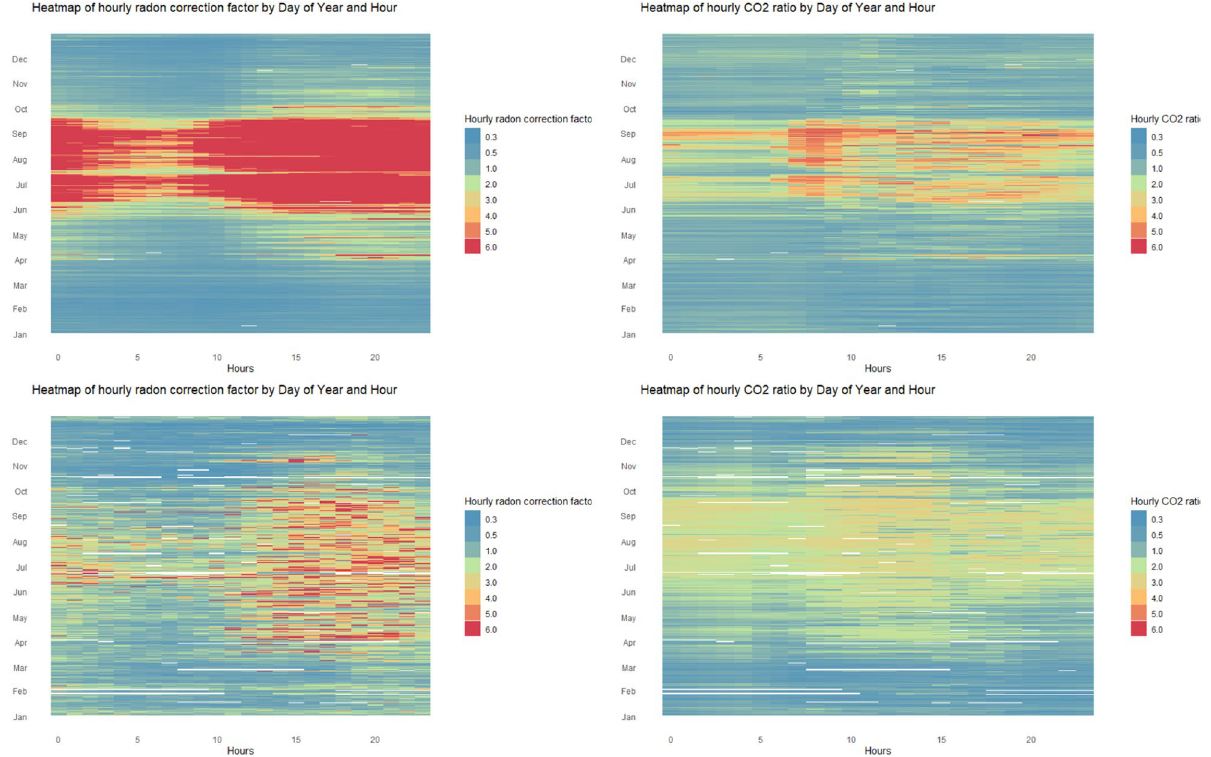
Figure 5. The heat map representation of TCF for radon concentration during one year (left): AIRC of 665 Bq/m 3 (top), AIRC of 65 Bq/m 3 (bottom). On the right are represented the ratios between the annual CO 2 concentration and the hourly means for the two houses. The figure was made using R (3.6.3) software (www. rstud io.